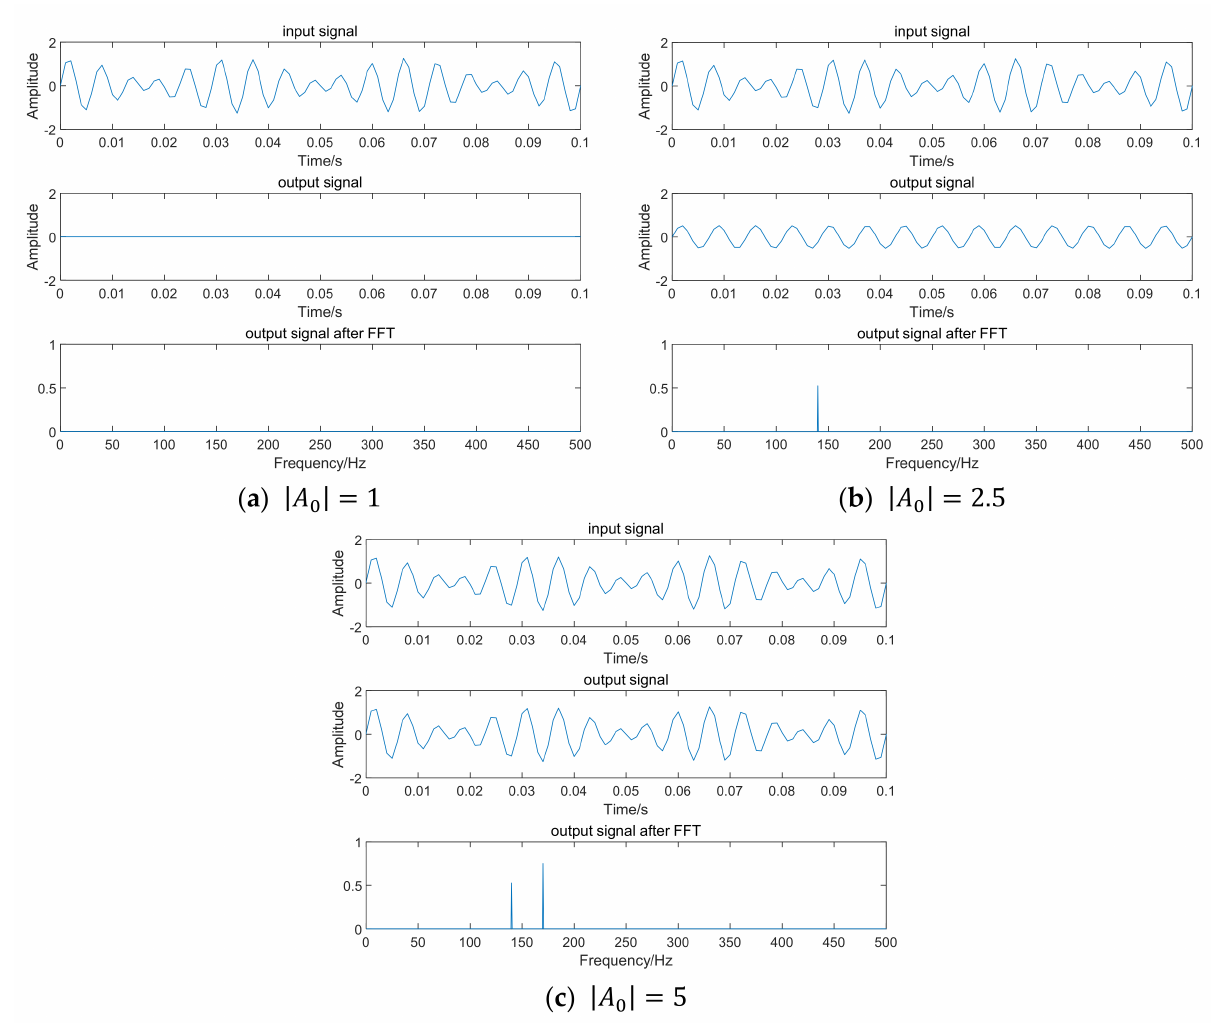
Figure 10. Input signal containing frequencies 140 Hz and 170 Hz is transformed by a nonlinear mass-in-mass phononic crystal with parameters shown in Figure 9. The different wave amplitude conditions are ( a ) | A 0 | = 1, ( b ) | A 0 | = 2.5 and ( c ) | A 0 | = 5. The FFT of output signal with varied amplitudes is shown on the bottom of each